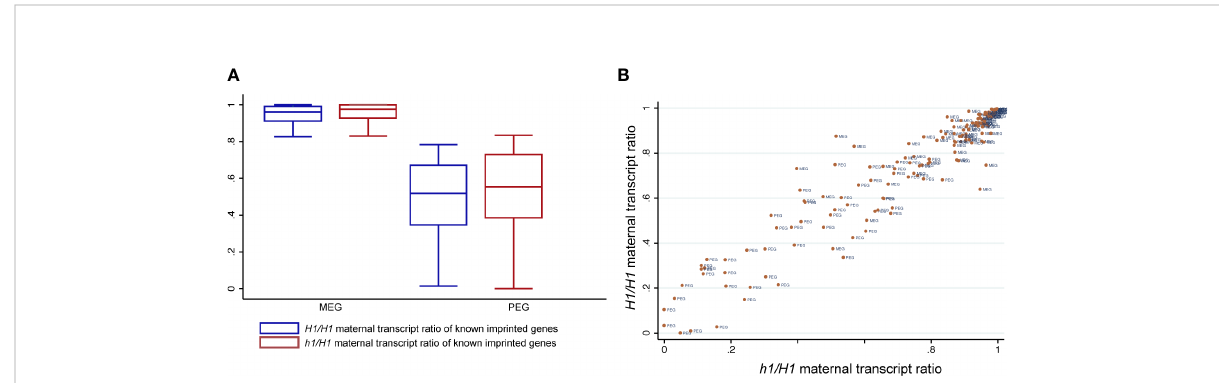
FIGURE 5 Known imprinted genes and their status of imprinted expression in H1/H1 and h1/H1 endosperm. (A) Boxplot showing the distribution of maternal transcript proportions of selected MEGs and PEGs in H1/H1 and h1/H1 endosperm. (B) Scatterplot showing the correlation of maternal transcript proportion of each imprinted gene between H1/H1 and h1/H1